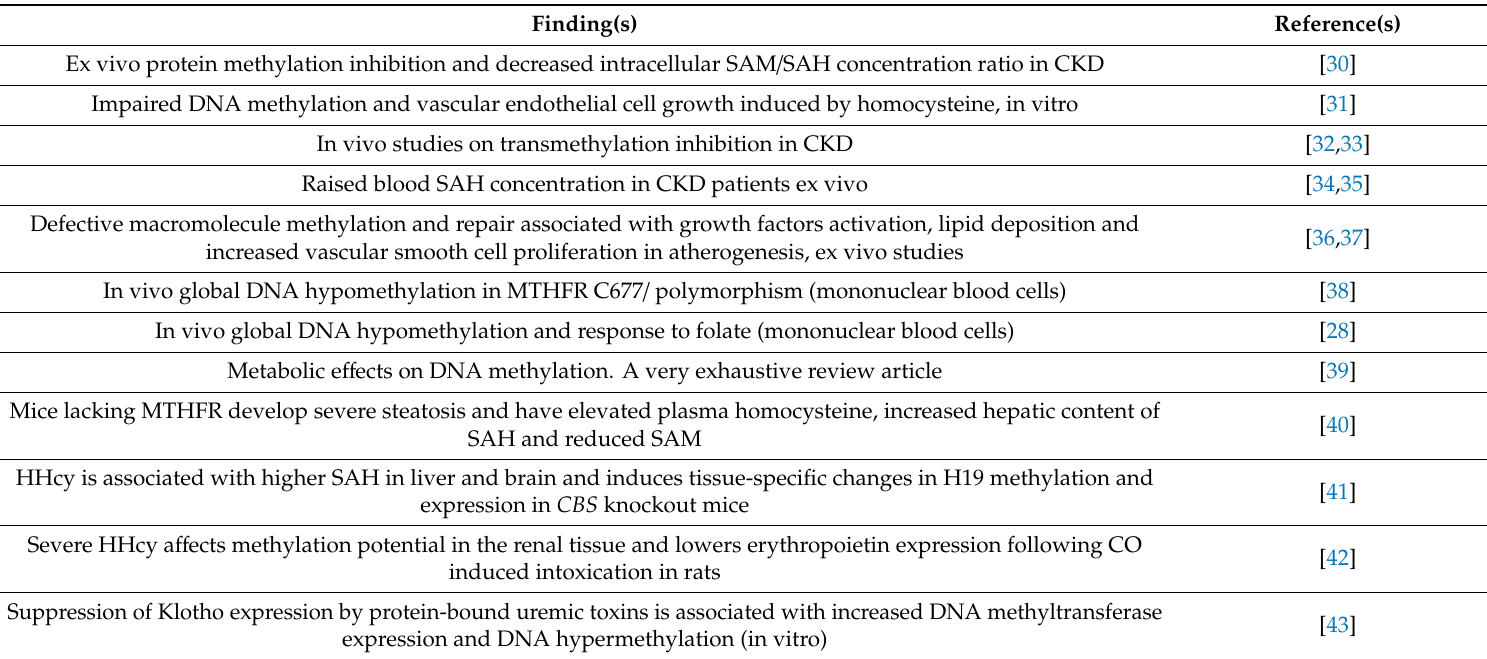
Table 3. Milestones in the history of disease-relevant derangements of one carbon metabolism, sulfur amino acid metabolism, and transmethylation